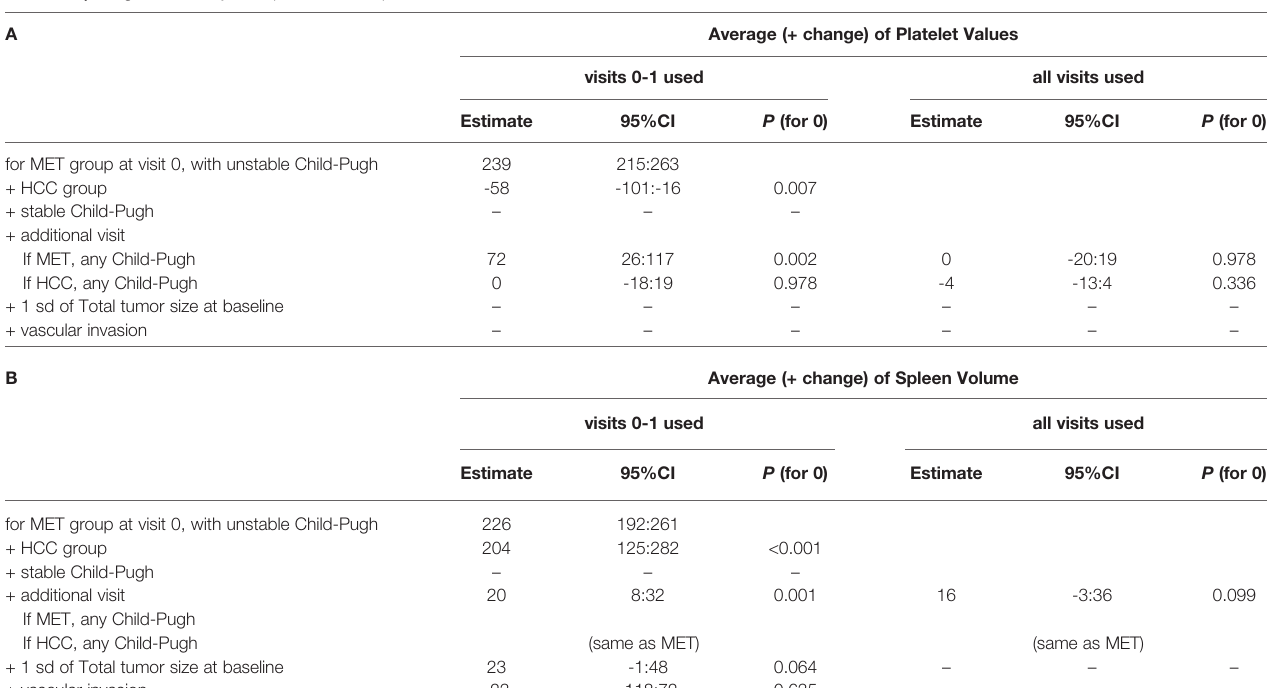
TABLE 2 | Longitudinal analysis of platelets and spleen